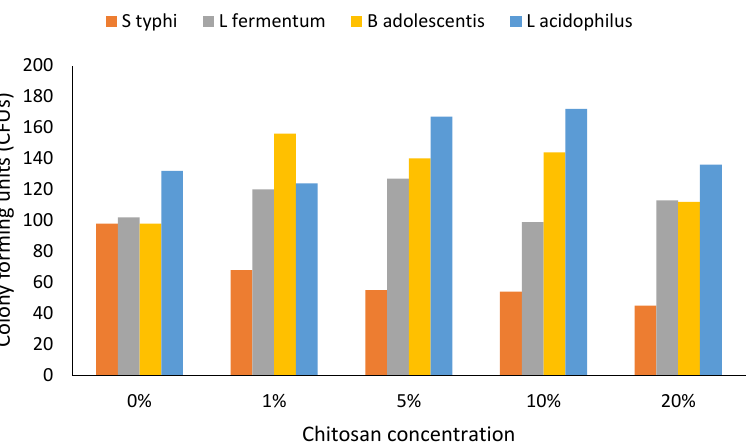
Figure 1. Growth of bacterial cells in chitosan-amended media (24 h). n = 3. Abbreviation: S typhi: Salmonella typhi , L fermentum: Lactobacillus fermentum , B adolescentis: Bifidobacterium adolescentis , L. acidophilus: Lactobacillus acidophilus. Bacterial growth in 0%, 1%, 5%, 10% and 20% chitosan-supplemented media was monitored at 24 h. Bacterial growth was measured in colony-forming unit per millilitre (CFU/mL).